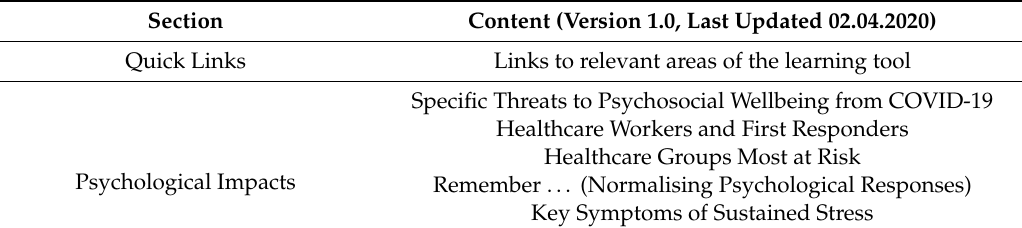
Table 1. Outline of Package Content for Version